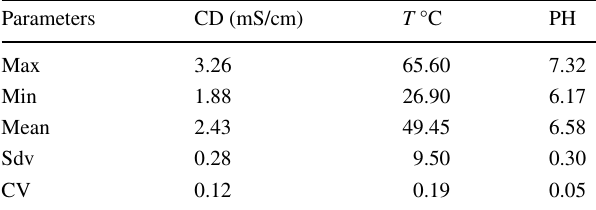
Table 2 The statistic summary of in-situ parameters Parameters